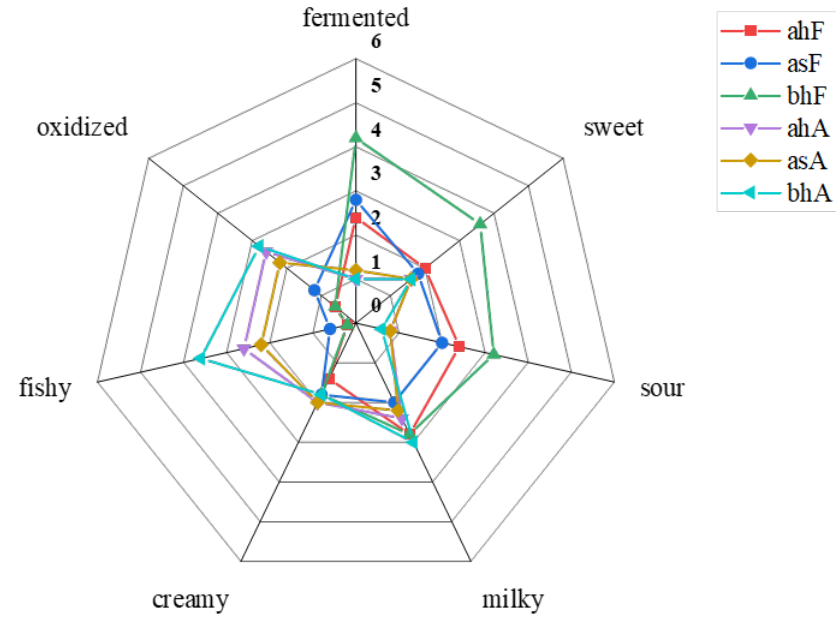
Figure 1. Odor profile evaluation of the six samples.